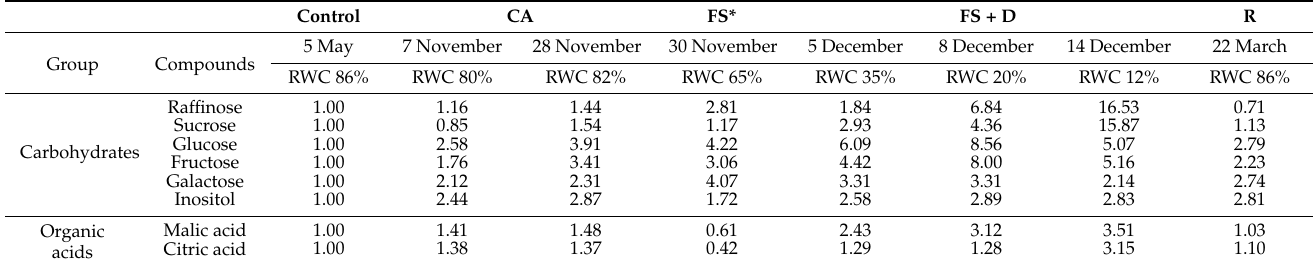
Table 2. Relative changes in concentration of different carbohydrates and organic acids measured in leaves of Haberlea rhodopensis collected after exposure to low temperatures during cold acclimation (CA; period: 7–28 November), after short-term exposure to freezing temperatures (FS; − 10 ◦ C, 30 November), after longer-term exposure to freezing temperatures when significant desiccation occurred (FS + D; period: 5–14 December) and after recovery of plants in early spring (R; period: 22 March). Data are expressed in arbitrary units (fold changes) normalized to the amount found in control samples collected in May. Percentages of RWC of leaves are reported at each time